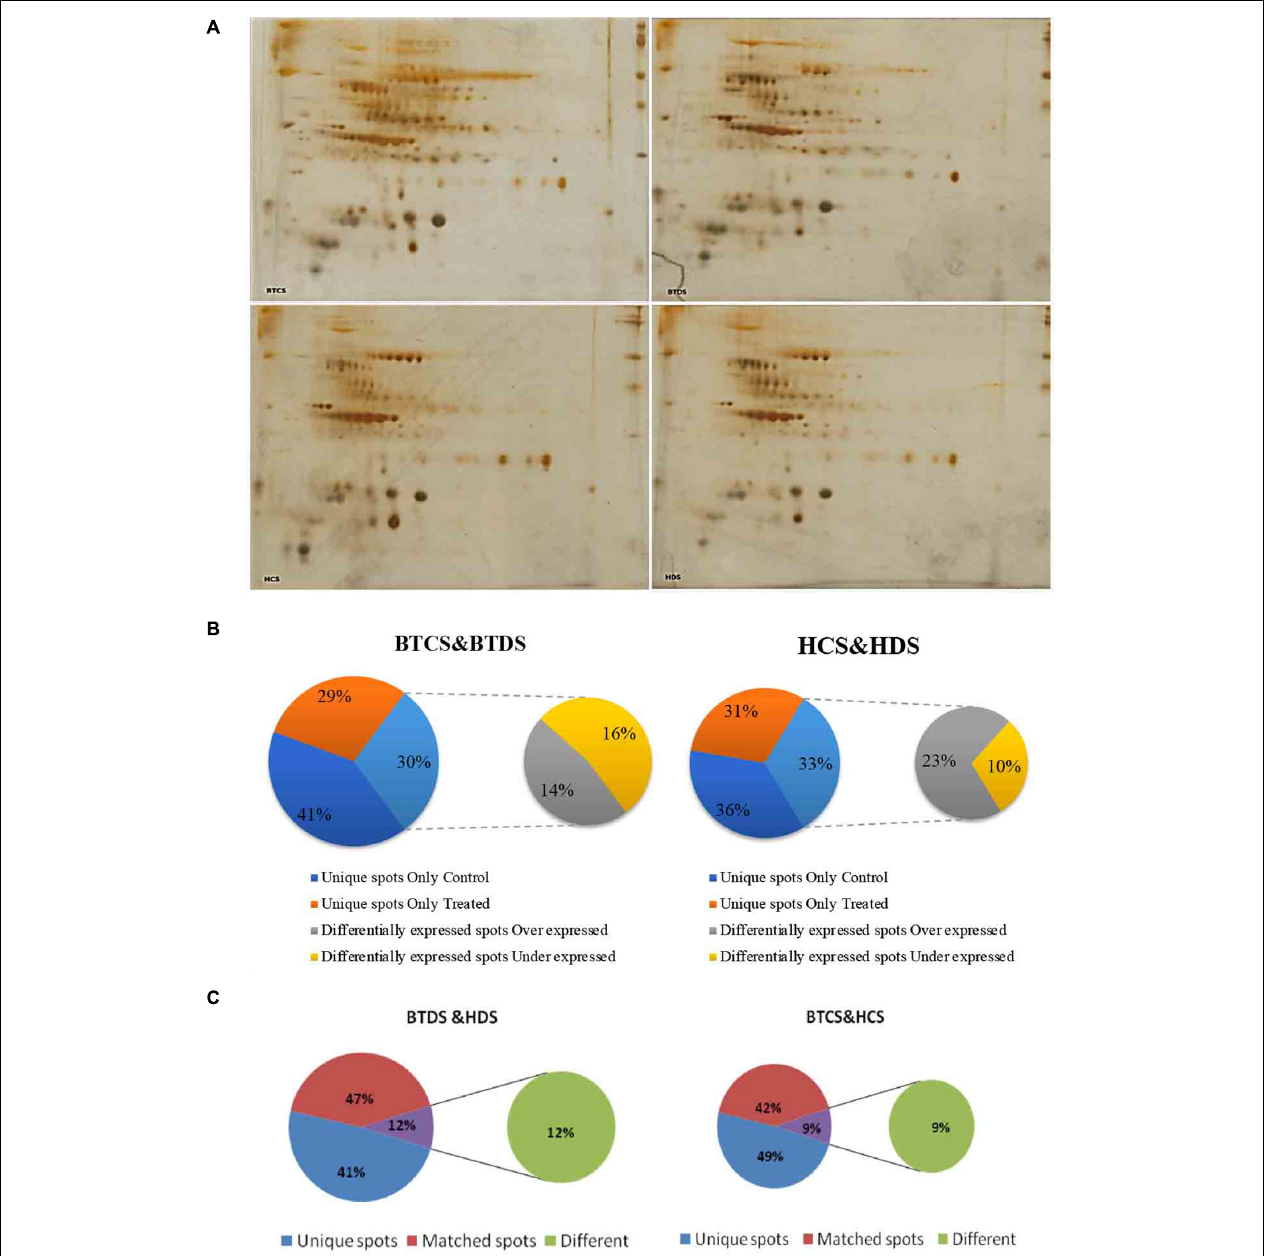
FIGURE 4 | (A) 2-DE analysis of protein. Proteome maps of Intra- hirsutum Hybrid ( Gossypium hirsutum ) cotton varieties (BT hybrid—BTCS and BTDS and Non-Bt varieties—HCS and HDS). The numbered protein spots were identified by MALDI-TOF from BTCS and HCS grown in well-watered conditions, and BTDS and HDS grown under drought stress with 200 mM mannitol. (B) Venn diagrams of BTCS/BTDS and HCS/HDS. Venn diagrams representing the overlap of identified DEP spots, which were underexpressed and overexpressed. Unique spots in between groups such as BTCS and BTDS, and HCS and HDS. (C) Venn diagrams of BTCS/HDS and BTCS/HCS. Venn diagrams representing the overlap of identified DEP spots, which were unique spots, different spots, and matched spots in between groups such as BTDS and HDS, and BTCS and